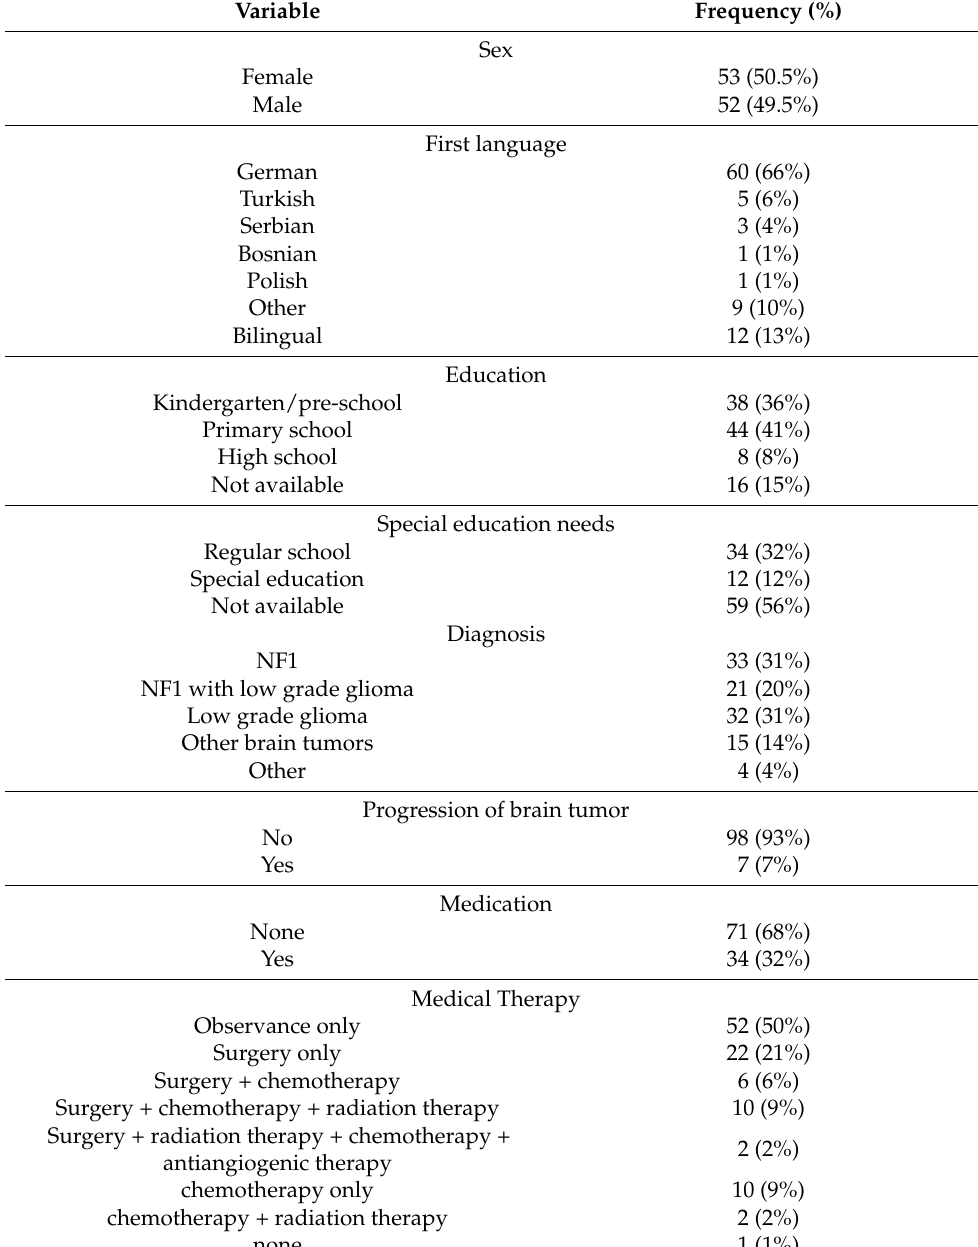
Table 1. Descriptive date (Sociodemographic and medical